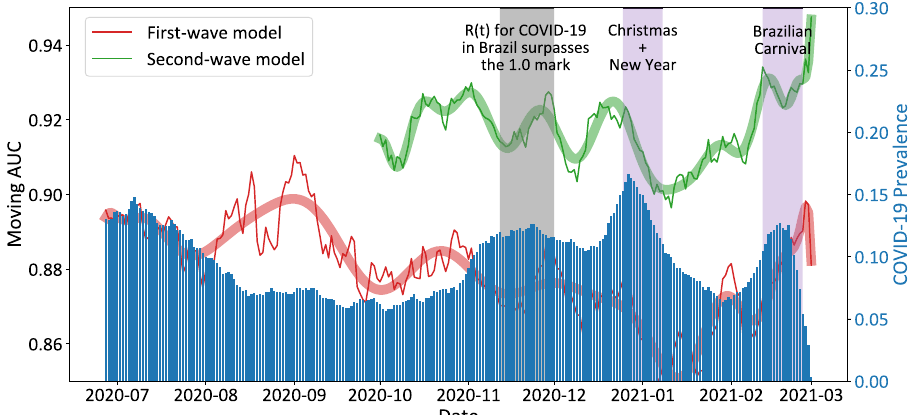
Fig. 3 AUROC fl uctuation over time considering a 7-day sliding window. The red line represents the model trained only on the fi rst wave of COVID-19 in Brazil data (up to 2020-06) while the green line represents a model trained with data immediately before the start of the second wave of COVID-19 in Brazil (up to 2020-10). Thinner lines depict the measured AUROC values while thicker lines illustrate their respective trends. The second wave model can retain performance during the second wave while the performance of the fi rst-wave model deteriorates. Key events are marked in gray and purple. N = 357,956 CBCs.